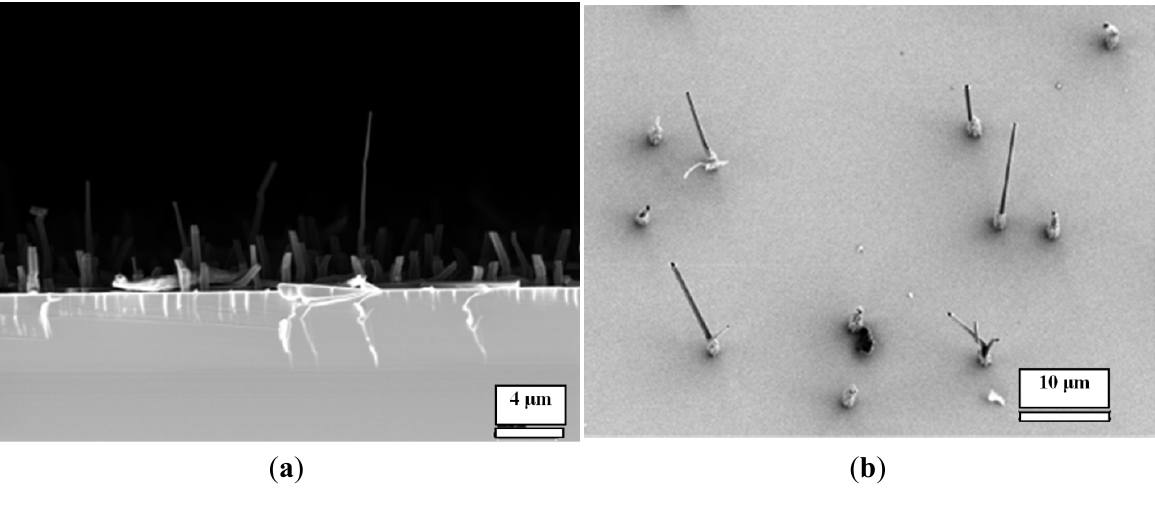
Figure 5. SEM images of micro-/nano-pillar arrays prepared from submerging gold-covered silicon substrates in a 2-mL mixture of M and CA till most of the water was evaporated